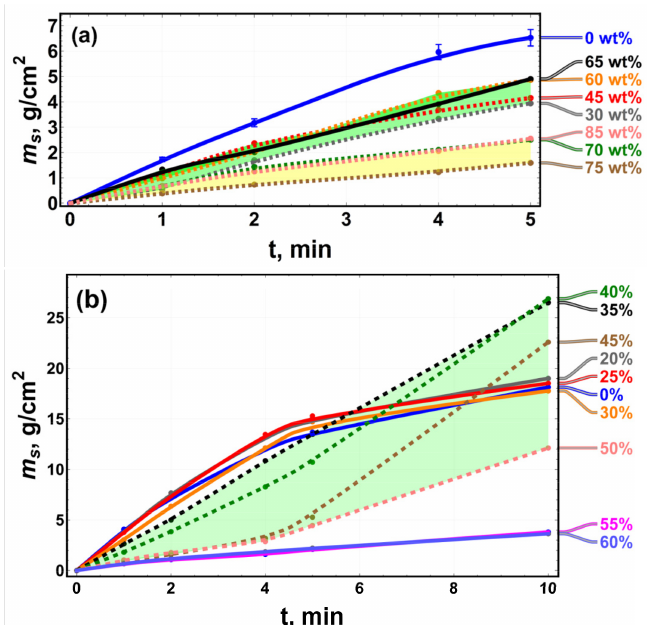
Figure 6. Producer gas weight per square centimeter of the irradiated fuel area versus time. The fuel compositions are P + RO ( a ) and L + RO ( b ). The weight fraction of rapeseed oil is shown on the right. The light flow intensity is 880 W/cm 2